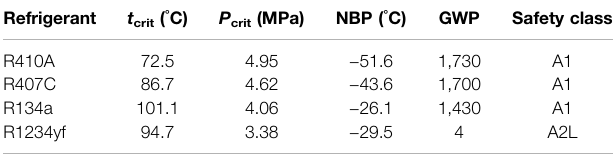
TABLE 1 | Necessary component parameters for the simulation program.